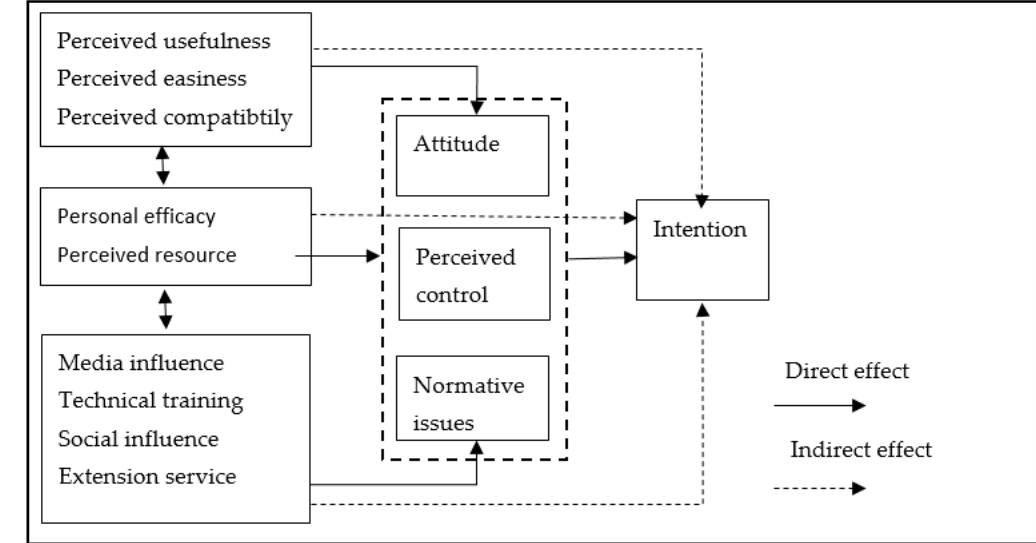
Figure 7. Conceptual framework for behavioral intention towards sustainable agricultural practices. Based on Zeweld et al. [12]. (Permission